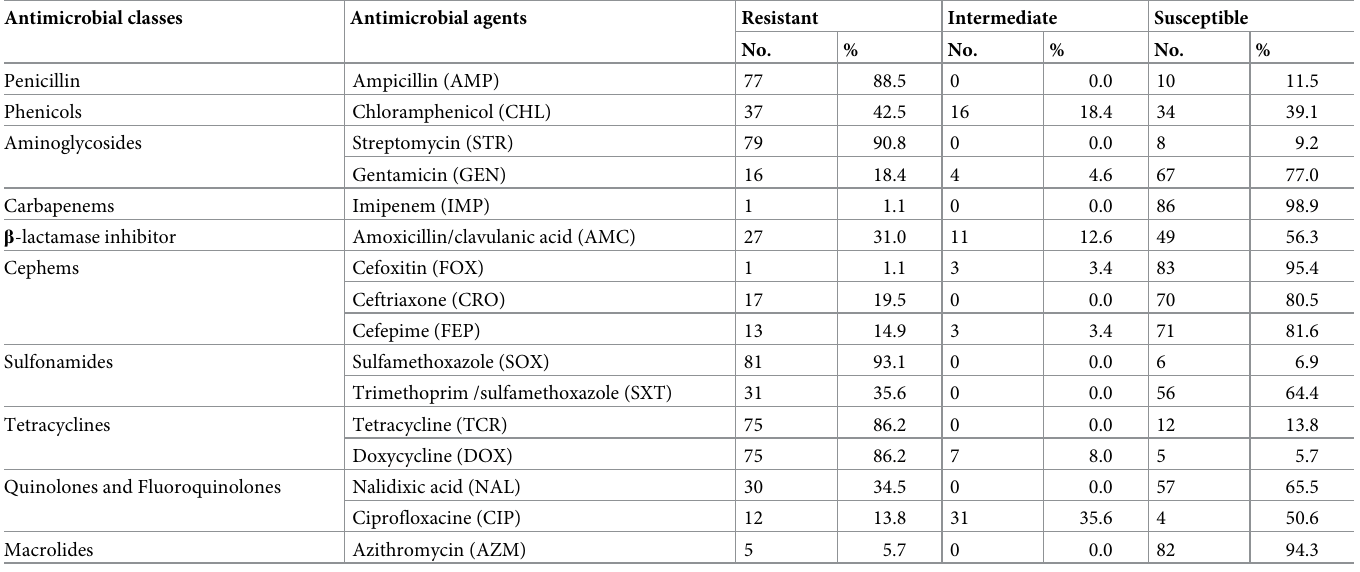
Antimicrobial resistance testing showed that Salmonella 4,[5],12:i:- isolates were shown to be the most resistant to sulfaoxazole (93.1%), followed by streptomycin (90.8%), ampicillin (88.5%), tetracycline (86.2%), and doxycycline (86.2%). Furthermore, Salmonella 4,[5],12:i:- isolates showed resistance to chloramphenicol (42.5%), trimethoprim /sulfamethoxazole (35.6%), nalidixic acid (34.5%), and amoxicillin/clavulanic acid (31.0%), respectively (Table 1). The resistance to ciprofloxacin was 13.8%. However, 35.6% of isolates showed decreased sensi- tivity to ciprofloxacin (MIC � 0.12 μ g/mL). Notably, Salmonella 4,[5],12:i:- isolates showed resistance to imipenem and azithromycin in this study. More importantly, three isolates were Table 1. Antimicrobial resistance of 87 Salmonella 4,[5],12:i:- isolates. Antimicrobial classes Antimicrobial agents Resistant